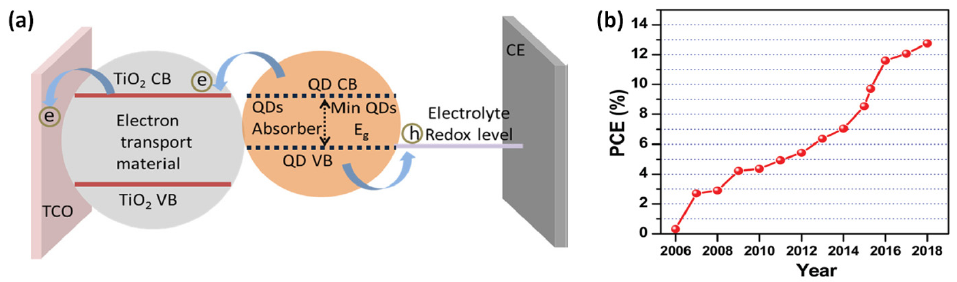
Figure 3. ( a ) Schematic diagram of quantum-dot-sensitized solar cells (QD-SSCs) [29]. ( b ) Evolution of the record PCE of QD-SSCs since 2006 (for cells based on a standard two-electrode configuration and tested under the irradiation of air mass (AM) 1.5 G one full sun illumination) [30]. (Reproduced from Ref. [29], 10.1016/j.solener.2020.04.044, and Ref. [30], 10.1039/C8CS00431E, respectively, with